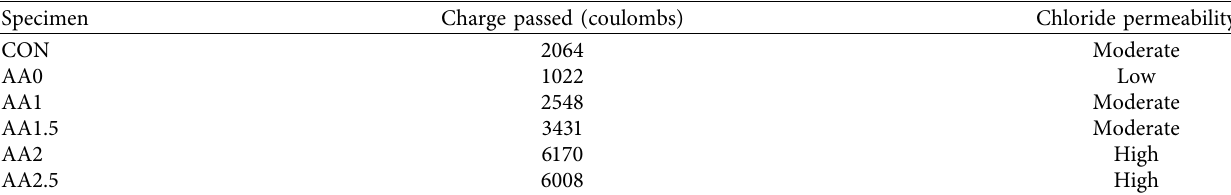
Table 3: Rapid chloride penetration test results for each